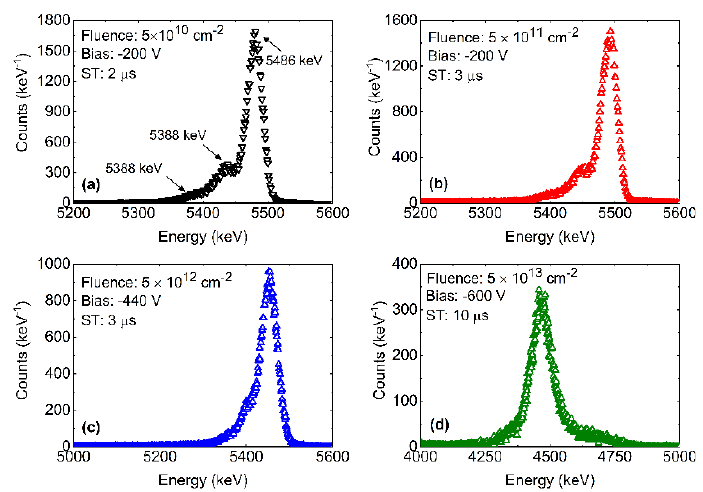
Fig. 4. (a)-(d) Pulse height spectra obtained for a Ni/250  m-4H-SiC SBD exposed to a 241 Am alpha source and irradiated with different neutron fluences.